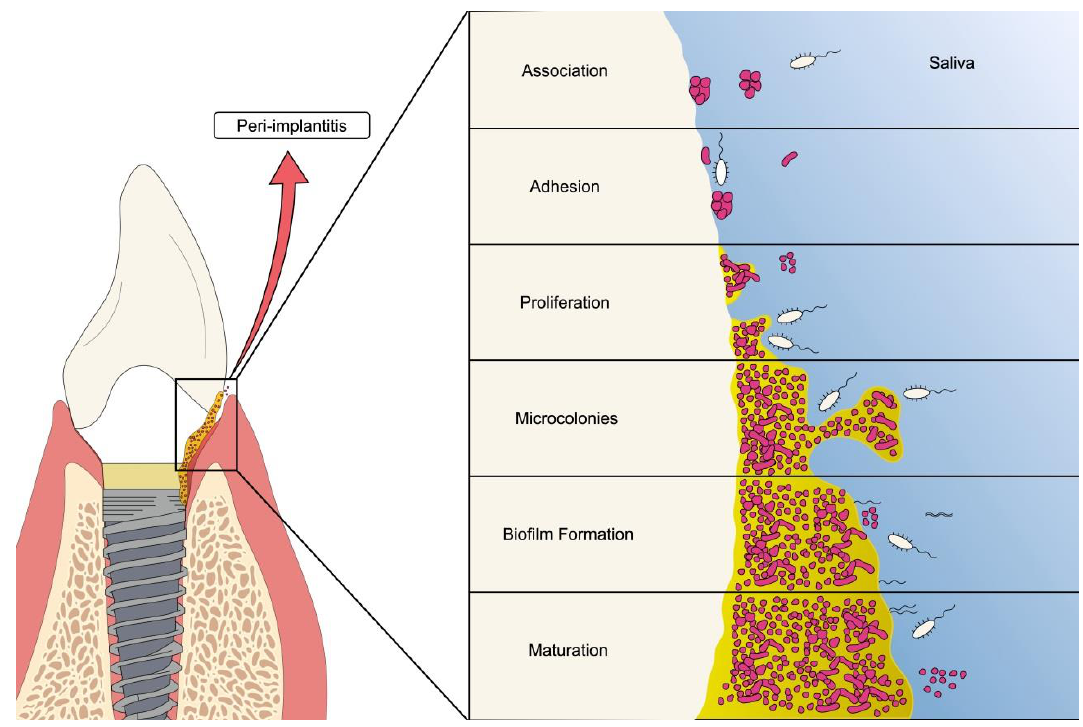
Figure 2. Schematic representation of oral biofilm formation on dental implants. The figure shows the different stages of bacterial biofilm formation ranging from adhesion to the establishment of the mature colony.